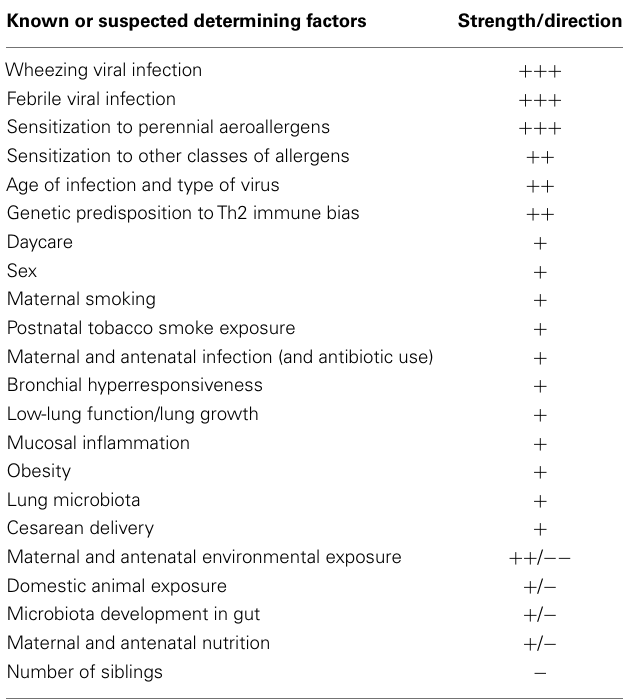
Table 1 | Known and presumptive factors though to influence the development and persistence of asthma during early childhood